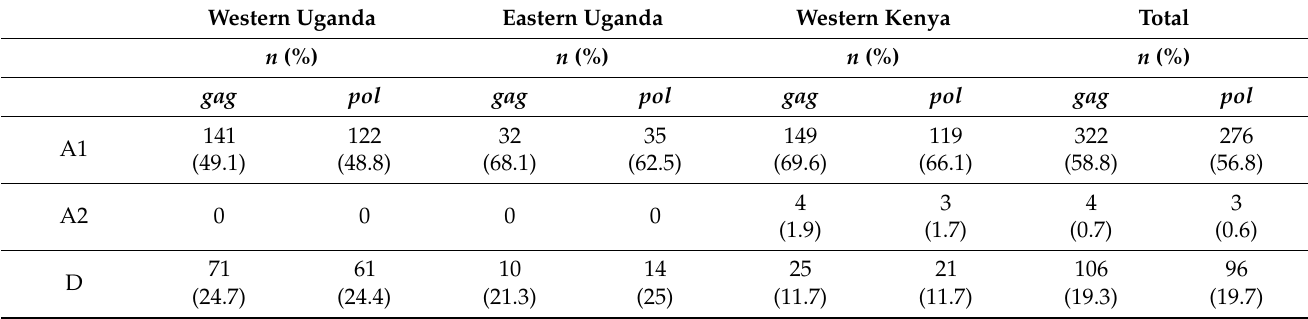
Table 3. gag ( n = 548, NA = 1) and pol ( n = 486, NA = 2) HIV-1 subtype distribution by region. Western